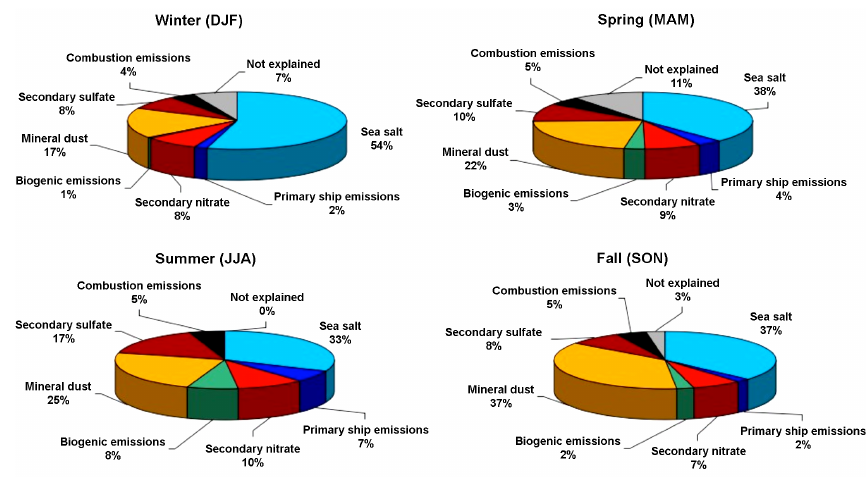
Figure 8. Seasonal relative contributions to PM 10 concentration (average over the years 2007–2008). Factors may sum to more than 100% due to number rounding.